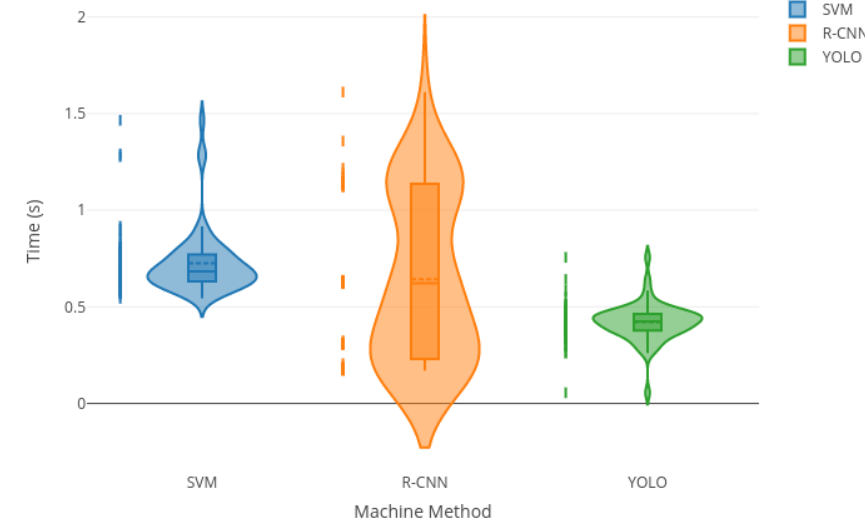
Figure 7. Evaluation time per method. The overall processing time is more variable in the R-CNN method because process to obtain binary masks that fit each detection is often computationally expensive, so this causes a longer detection time of number of lettuces per image. SVM and Yolo obtained less variable processing time because their architectures are less